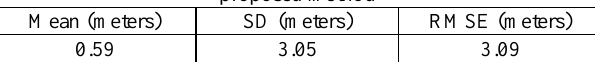
Table 1. Statistical parameters of height error created